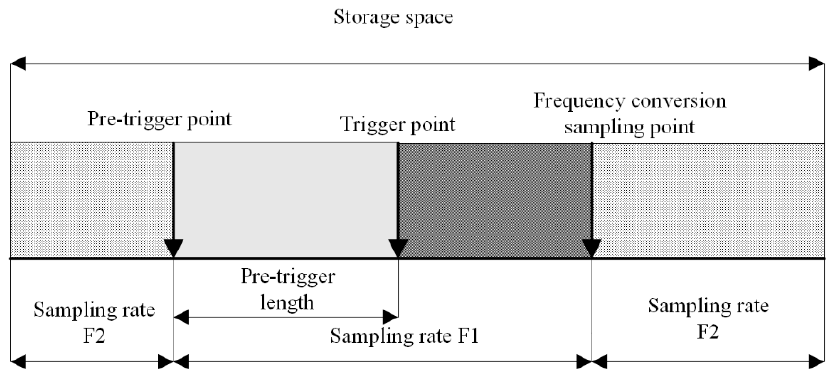
Figure 4. The principle of variable frequency sampling speed data acquisition card.